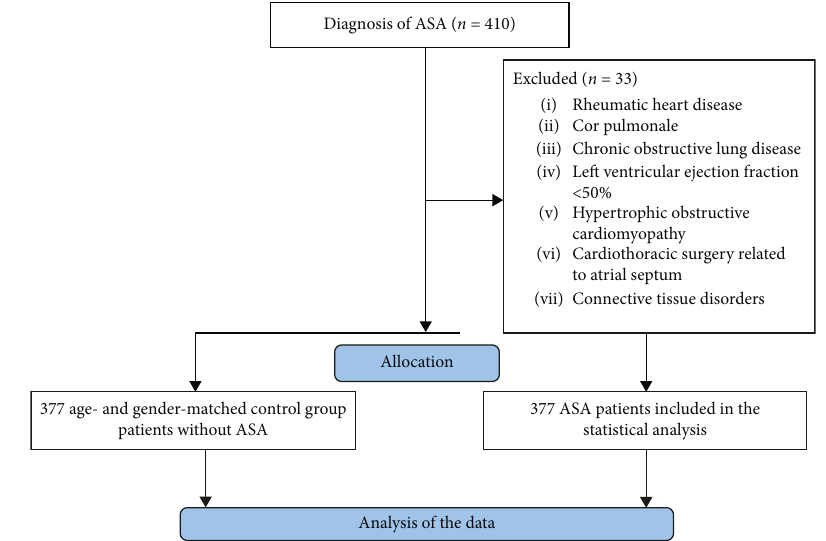
Figure 1: Flowchart of the study. ASA: atrial septal